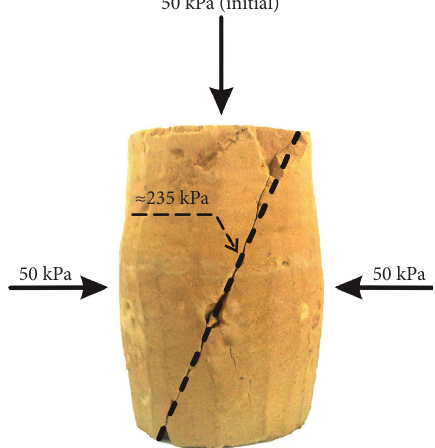
Figure 9: Shear failure within loess sample 1